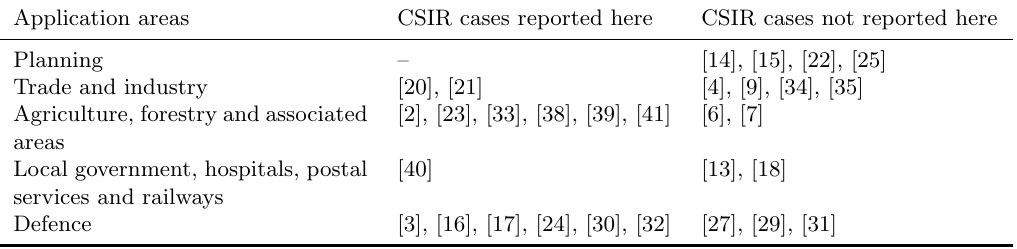
Table 1: Application areas of OR